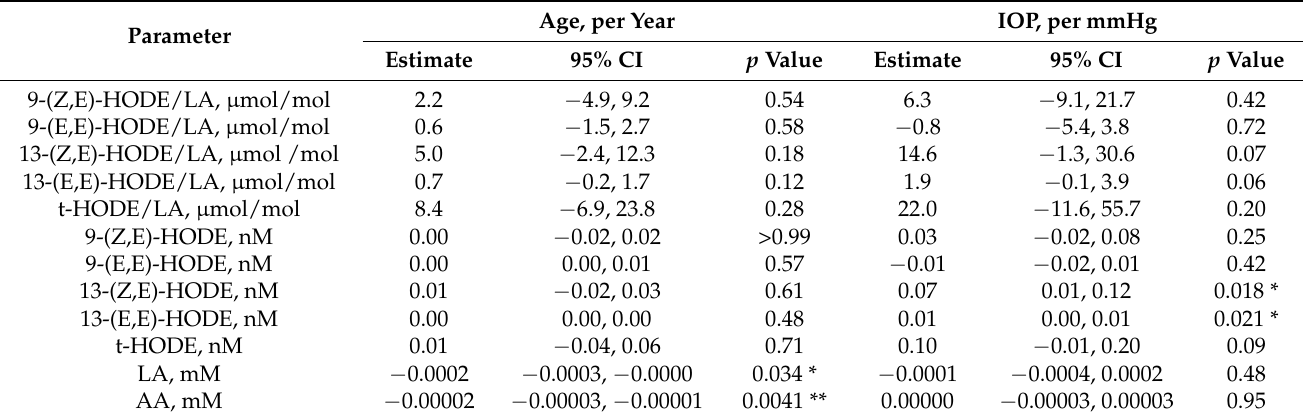
Table 3. Possible association between HODE levels and age or IOP.